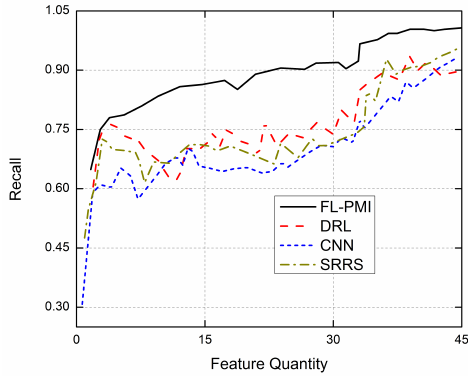
Figure 9. Recall analysis for varying feature